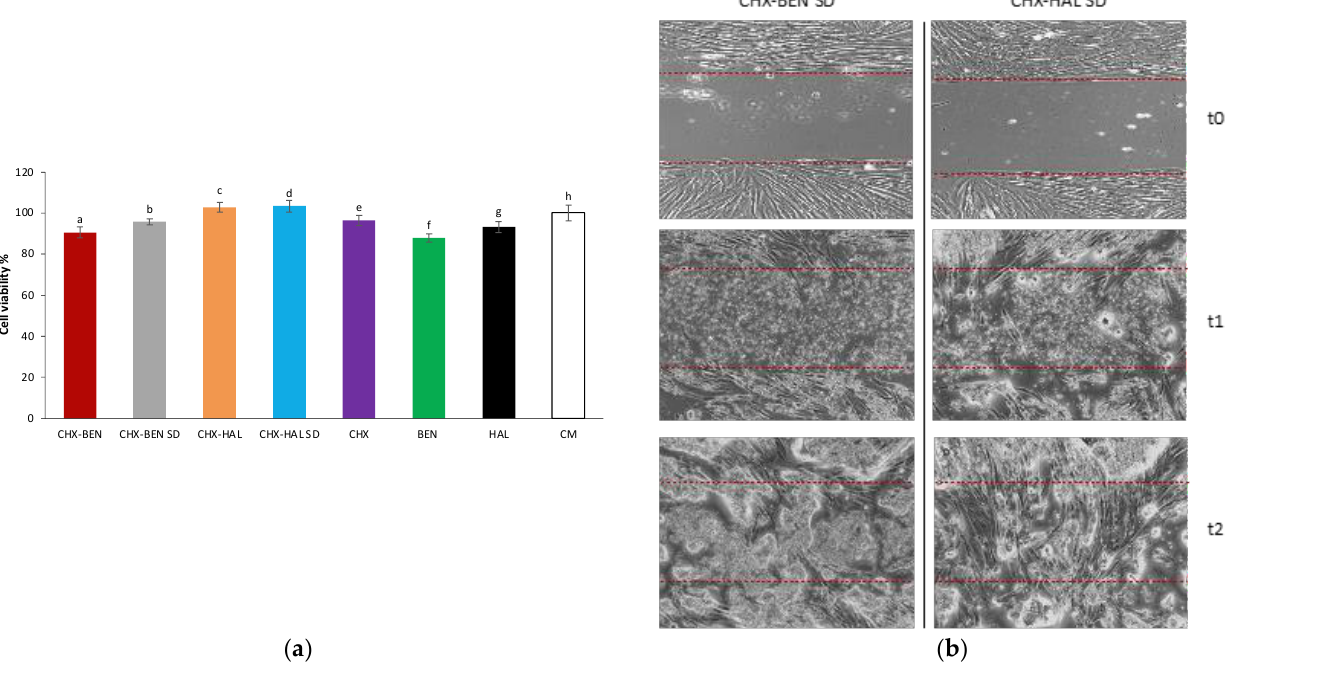
Figure 12. ( a ) Viability percentage values calculated after cell contact with samples CHX – BEN, CHX – BEN SD, CHX – HAL, CHX – HAL SD and references BEN, HAL and CHX (mean values ± s.d.; n = 6). CM was considered as control. ANOVA one-way, post hoc Scheffè test ( p < 0.05: a vs. c, d, h; b vs. c, d, h; c vs. e, f, g; d vs. e, f, g; e vs. f; f vs. g, h; g vs. h. ( b ) Microphotographs (maginification 10X) of cell substrates taken at t 0 (namely, after insert removal), at t 1 (after 24 h of sample treatment) and at t 2 (after 72 h of sample treatment), using optical microscope. Two red dotted lines were drawn corresponding to the cell-free gap so as to better visualize the area of cell migration. CHX: chlorhexidine dihydrochloride; BEN: bentonite; HAL: halloysite; CHX – BEN and CHX – HAL: na- nohybrids obtained by intercalation solution technique; CHX – BEN SD and CHX – HAL SD: nano- hybrids obtained by spray-drying technique.